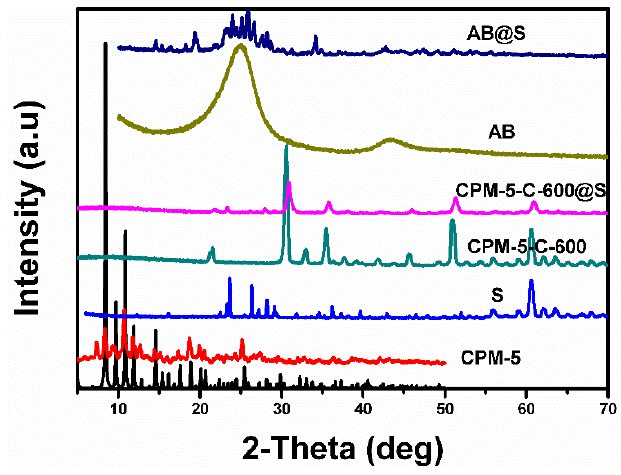
Figure 3. The XRD patterns ofCPM-5, S, AB, AB@S, CPM-5-C-600 and CPM-5-C-600@S composites.